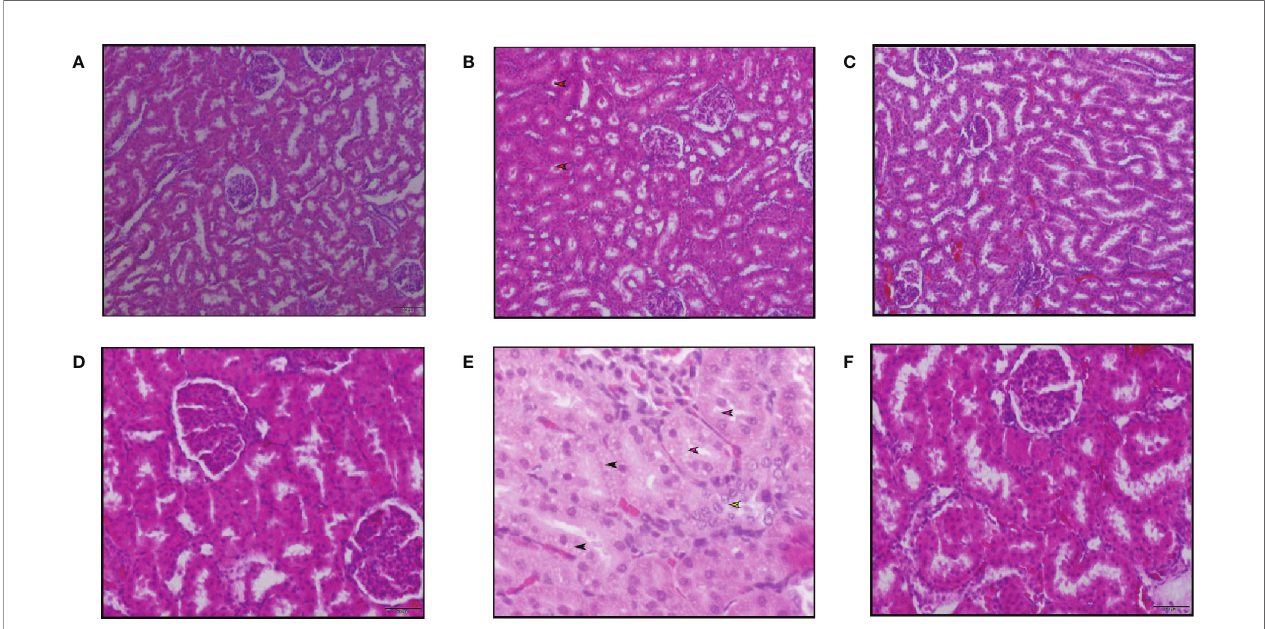
FIGURE 6 | Hematoxylin and eosin staining of kidney sections of Sprague Dawley rats treated with 15 mg/kg/day BW of Vehicle, SM21 and Amphotericin B groups after treatment for 5 days. Six micrographs taken from the cortex of kidney in Vehicle (A, D) , Amphotericin B (B, E) , SM21 (C, F) groups. Control groups [Vehicle and voriconazole (not shown)] showed no abnormality. SM21 treatment group (SM21 and its analogue) had similar fi ndings of the control groups along with mild tubular necrosis. Among tubular necrosis in Amphotericin B group, loss of the brush border of tubuli (pink arrow in Figure E ), mild tubular cell vacuolation (black arrow in Figure E ), intratubular cast formation (red arrow in Figure B ), disengagement of cells into lumen of tubuli (yellow arrow in Figure E ) were signi fi cantly observed. SD, Sprague